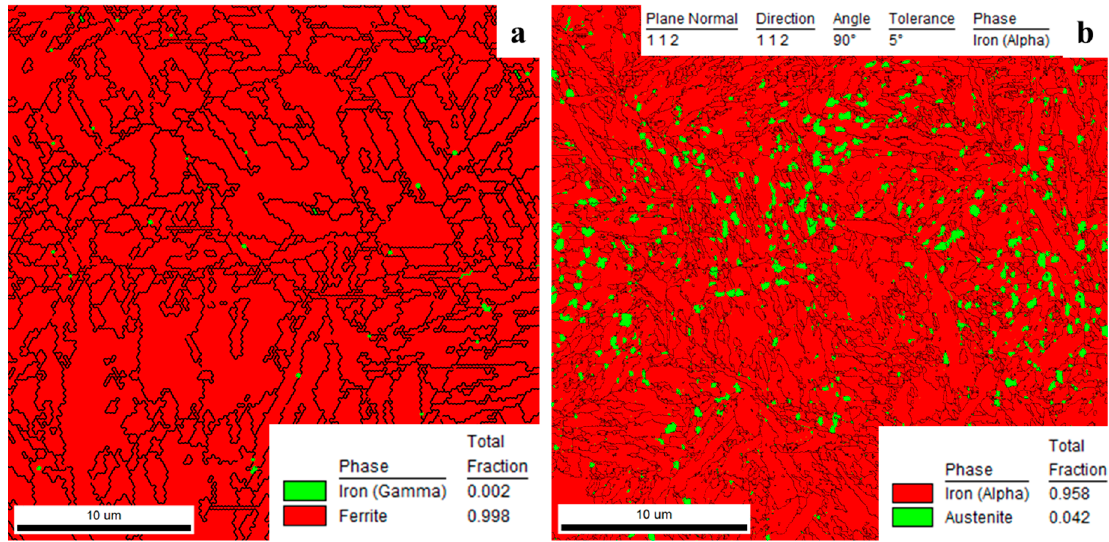
Figure 8. ( a ) Phase map of the CH sample which consists of 0.2% austenite, ( b ) phase map of the UFH sample in which the amount of austenite is considerably higher (4.2%). sample in which the amount of austenite is considerably higher